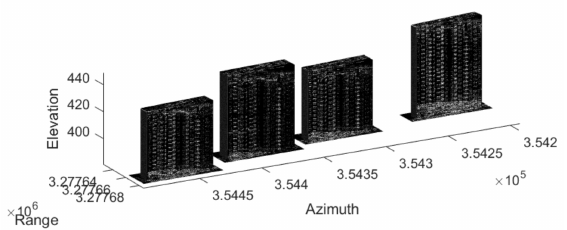
Figure 24. 3D reconstruction